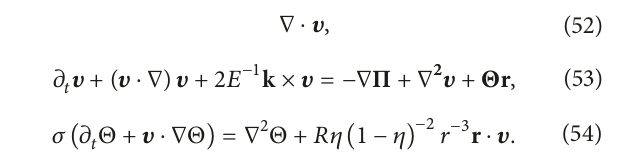
their counterparts obtained in Section 3.1 using the temporal HODMD method, retaining 25 and 71 spatiotemporal